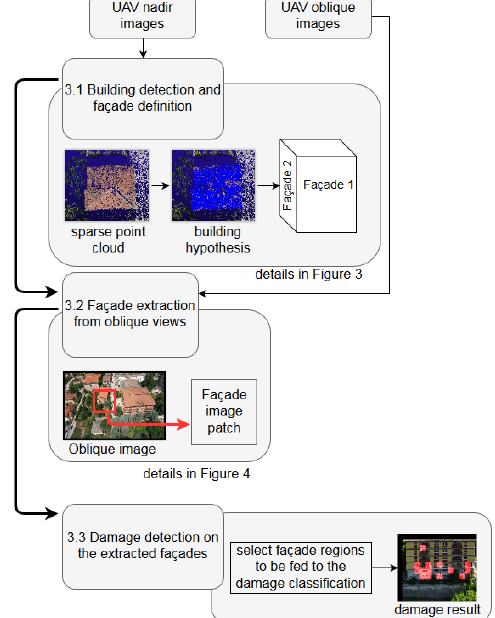
Figure 2 Overview of the method - divided into the three main